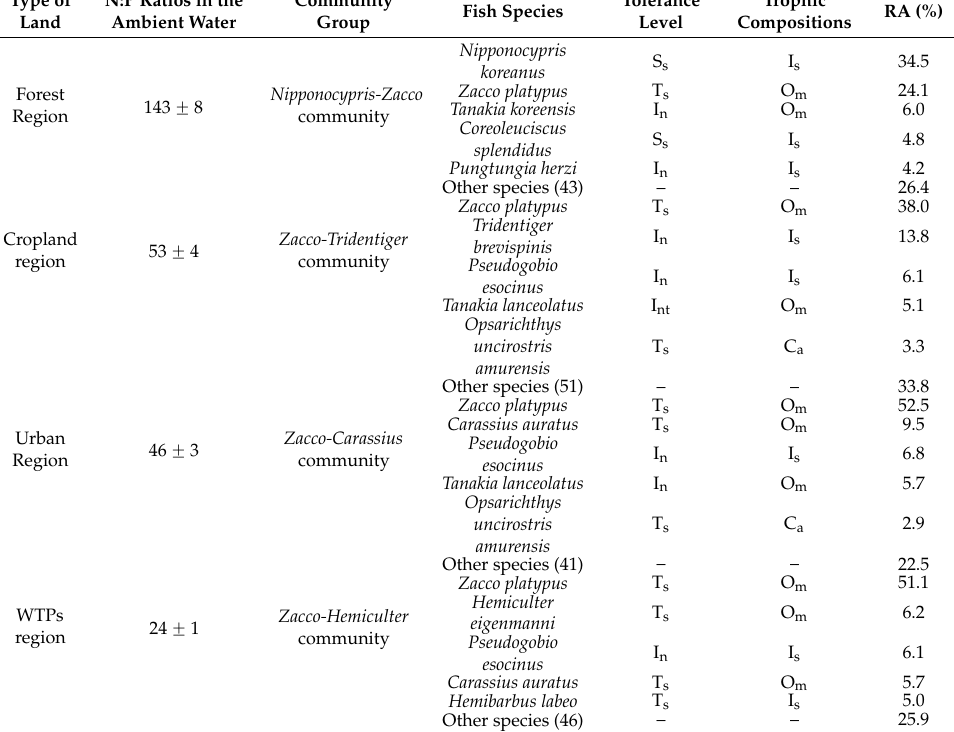
Table 2. N:P ratios in the ambient water (means ˘ SE), fish community, and fish compositions (including tolerance level and trophic composition) according to type of land in the Geum River watershed.